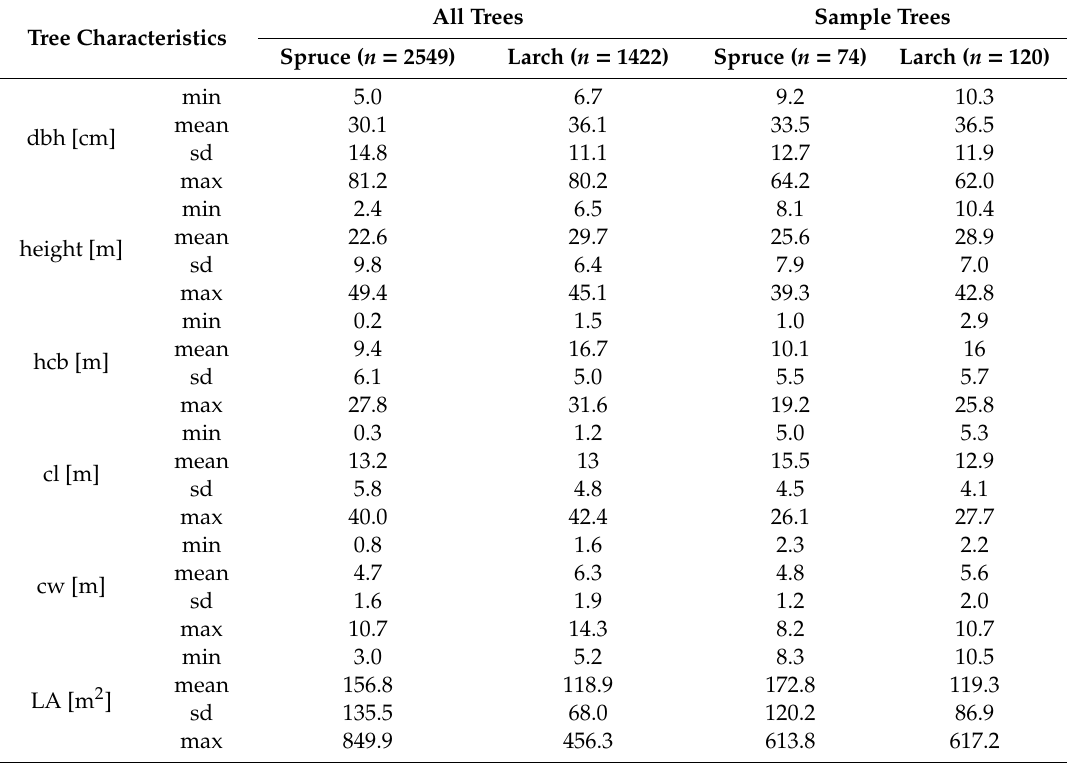
Table 2. Individual tree characteristics; dbh is the diameter at breast height, height is the total tree height, hcb is the height of the crown base above the ground, cl is the crown length, cw is the width of the horizontal crown projection, LA is the leaf area, sd is the standard